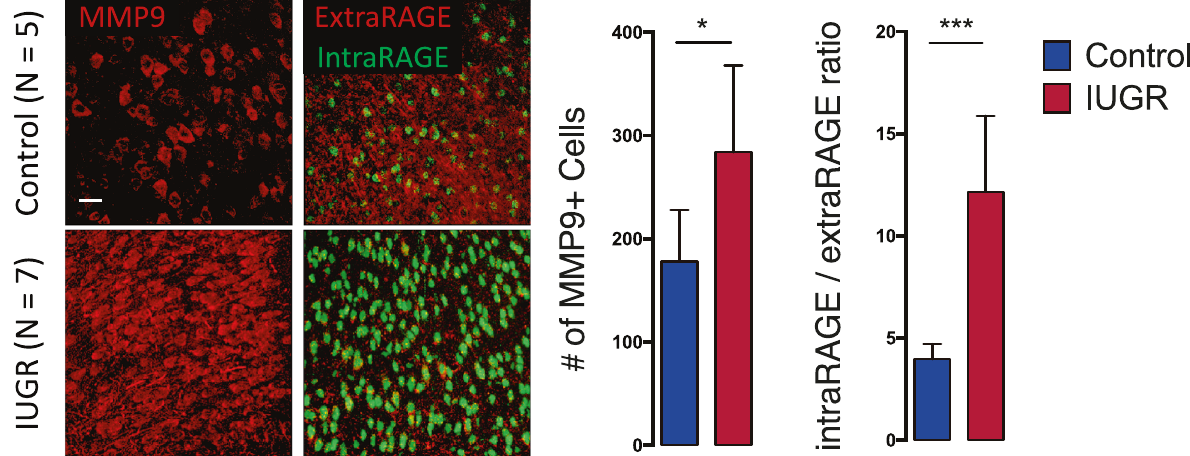
Fig. 3 Increased MMP9 and RAGE shedding in the low protein induced IUGR offspring at P35. Images for MMP9, and double immunostaining for intranuclear RAGE positive cells (green) and membrane-bound RAGE positive cells (red), in both control ( n = 5) and IUGR ( n = 7) groups. IUGR leads to signi fi cant increase in MMP9 + cells and RAGE ratio (number of intranuclear RAGE positive cells/membrane- bound RAGE positive cells) in the ACC as compared to controls. Results are mean ± STD, * p = 0.05, ** p < 0.01, **** p < 0.0001 Control vs IUGR. Scale bar: 30 μ